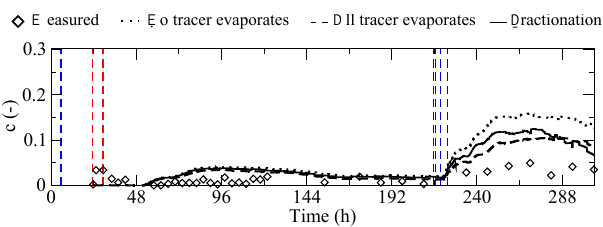
Figure 9. Measured and modeled average tracer concentration at the seepage face for the cases in which no tracer, all tracers, and some tracers (fractionation) leave the system with evaporation (sim- ulations i, j, and k of Table 3). The three simulations are run for α l = 0 . 001m and α t = 0 . 0001m. The vertical dashed lines indicate the timing of the three pulses of rain (red when the water is 2 H - enriched and blue when it is not).